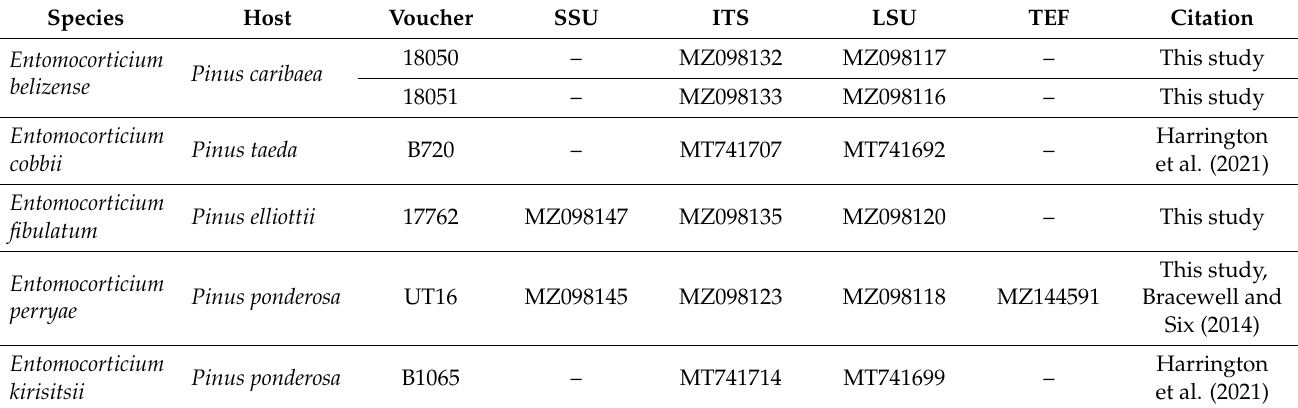
Table 2. Species used in the Russulales analyses and their GenBank accession